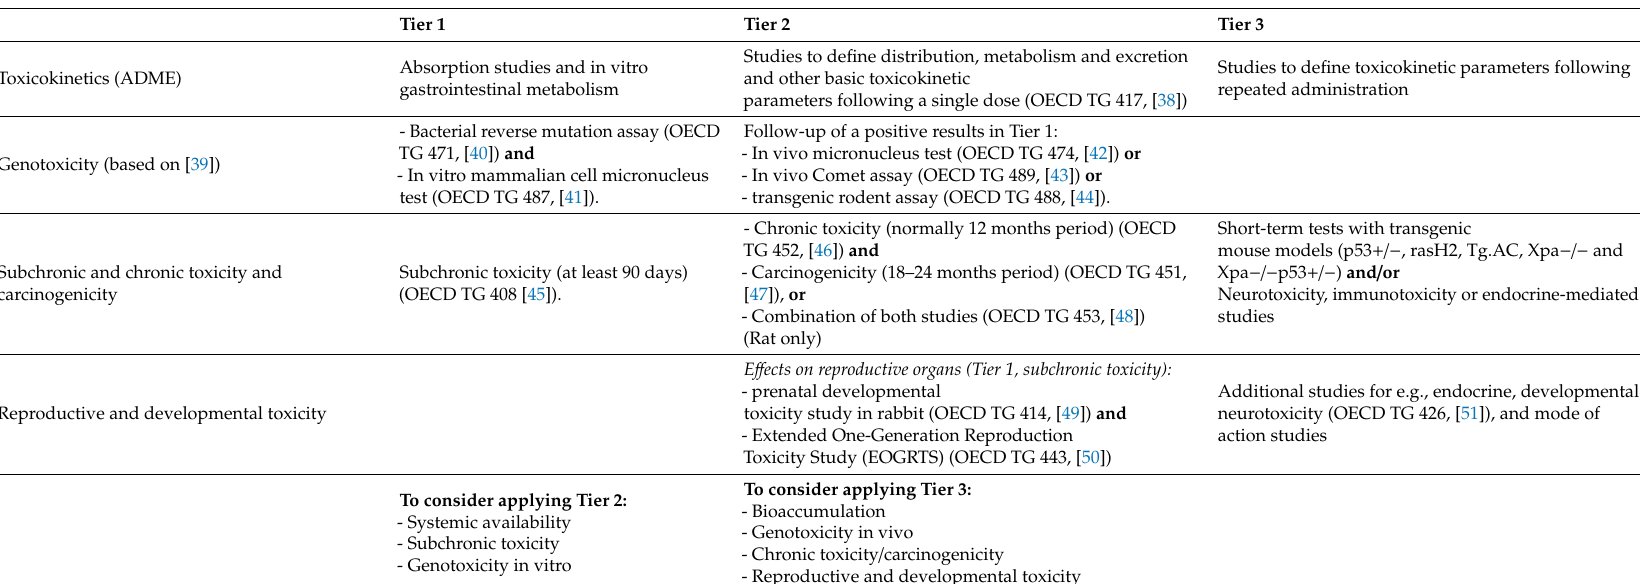
Table 3. Tier approach suggested by the European Food Safety Authority (EFSA) for the safety evaluation of food additives (EFSA,